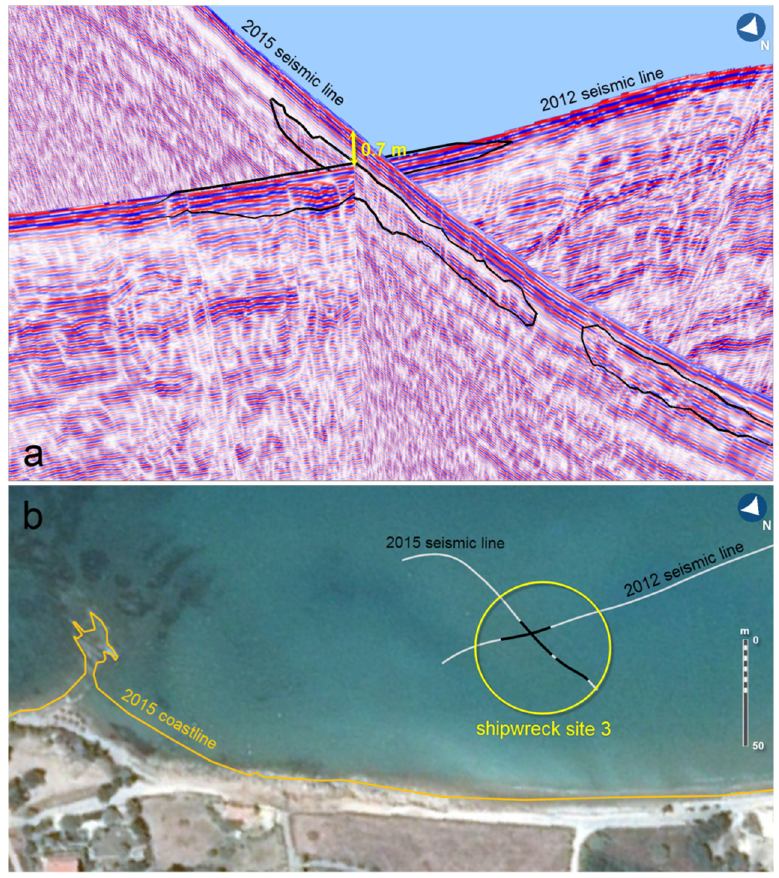
Figure 15. Spatio-temporal analysis of seismic and geospatial data over shipwreck site 3, showing net deposition of fine sediments in the time span 2012–2015 ( a ) A 3D fusion and interpretation of seismic data acquired in 2012 and 2015, documenting net deposition of 0.7 m of sand over the site, and outlining wreck-related structural features; ( b ) A 2D view of the seismic lines, the interpretation of wreck-related features, and coastlining data showing sand deposition on shore and seaward advance of the shoreline between 2013 and 2015. Background historical imagery: Google.